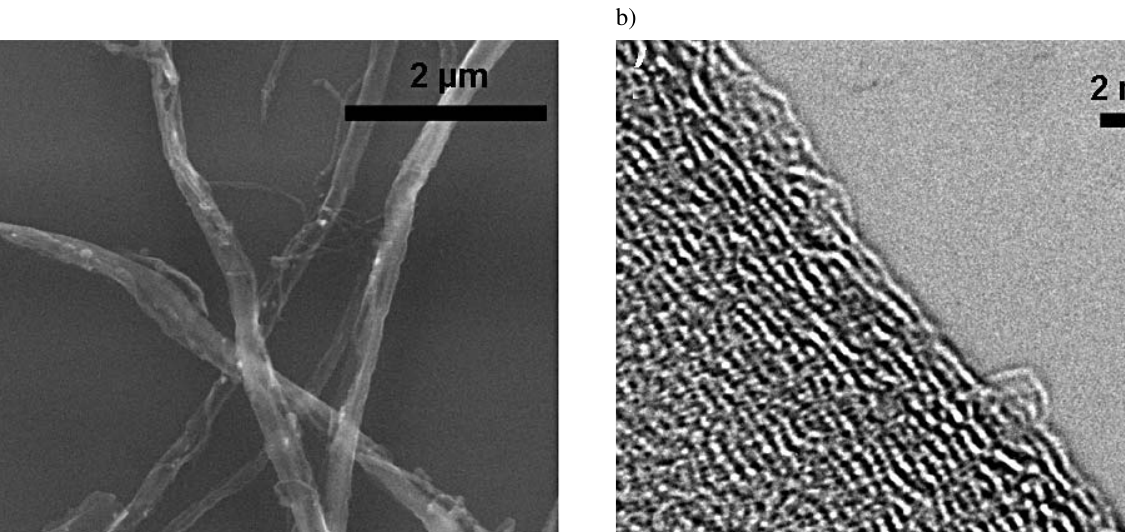
Figure 1 . Images of synthesized C